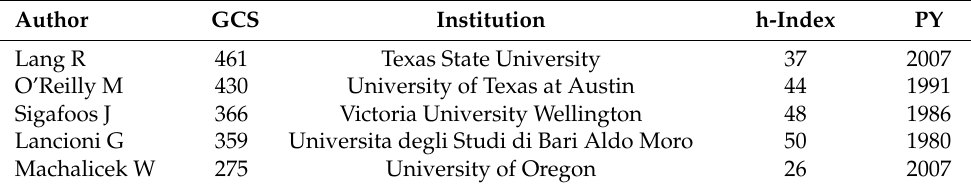
Table 3. Authors with the highest number of citations.